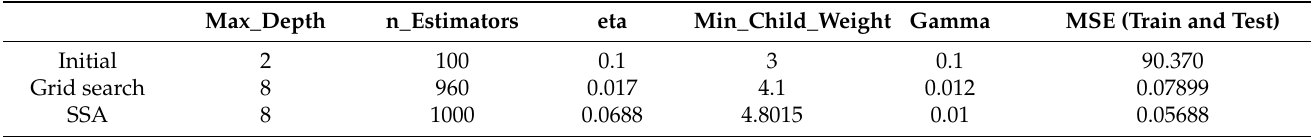
Table 8. Hyper parameters and MSE of the